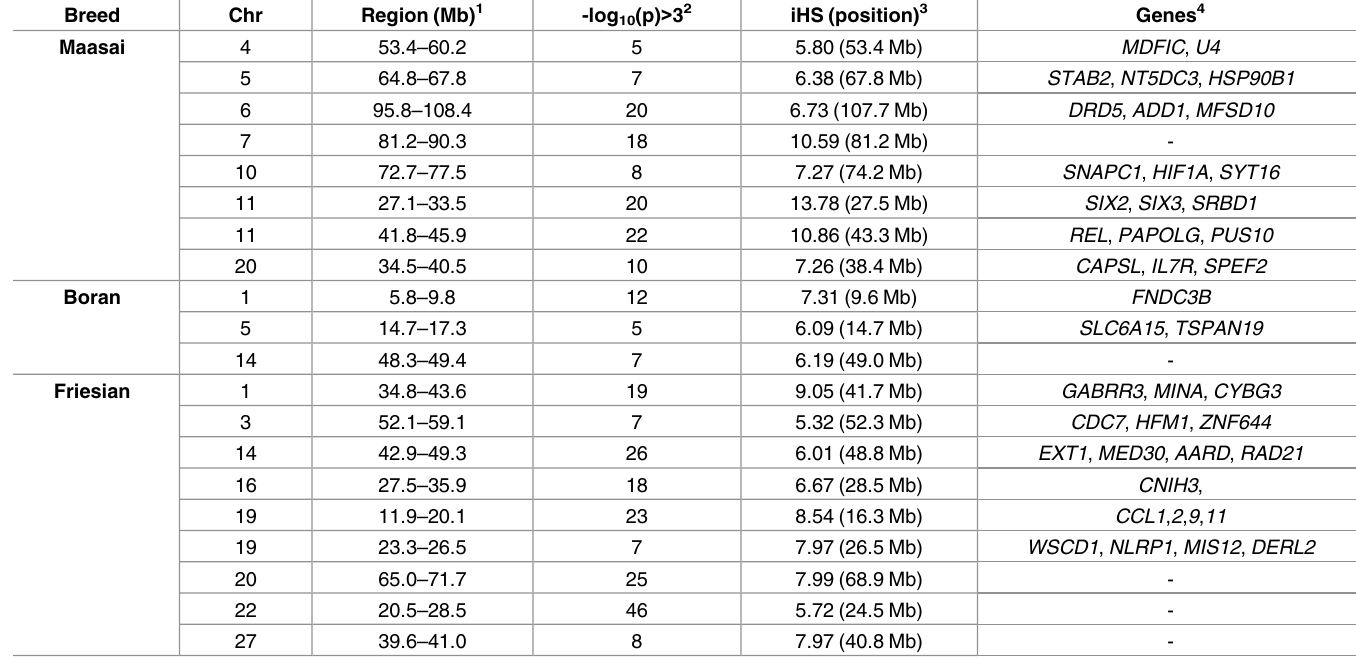
Table 3. Signatures of selection in Tanzanian shorthorn Zebu cattle and Boran breed.